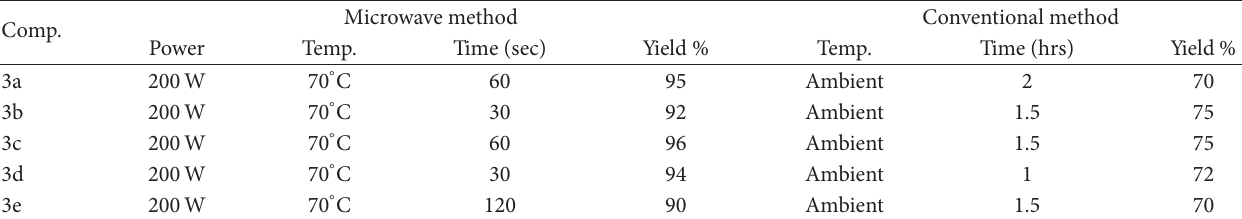
S 1: Synthesis of Schiff bases. T 2: Comparison of microwave and conventional